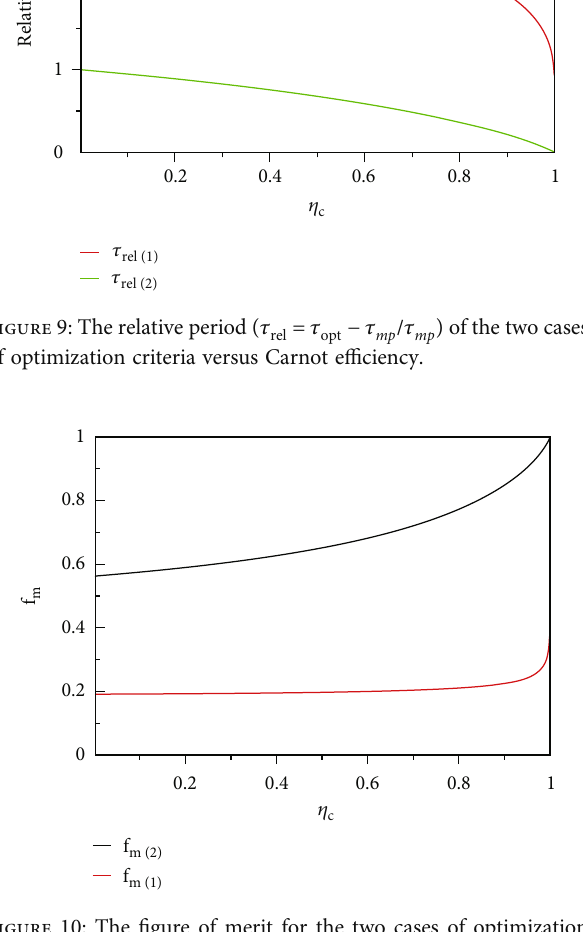
Figure 10: The fi gure of merit for the two cases of optimization criteria versus the Carnot e ffi